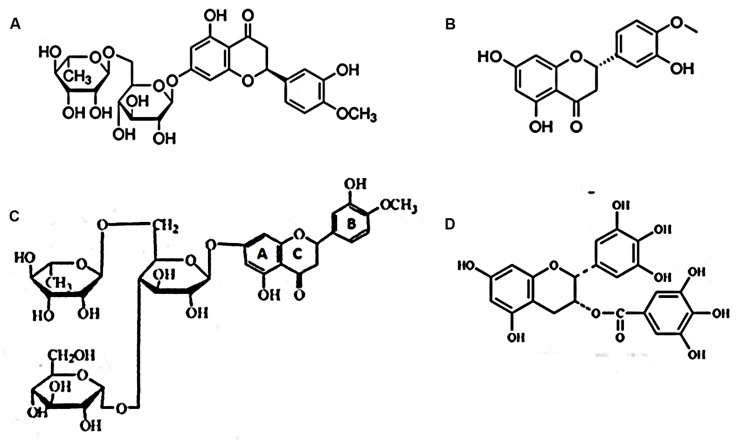
Selected flavanones reported to possess antiviral activity. (A) Hesperidin, a flavanone glycoside; (B) hesperitin, an aglycone of hesperidin; (C) α-glucosyl hesperidin (A semi-synthetic derivative of hesperidin. U.S. Patent number: 5,652,124); (D) EGCG.